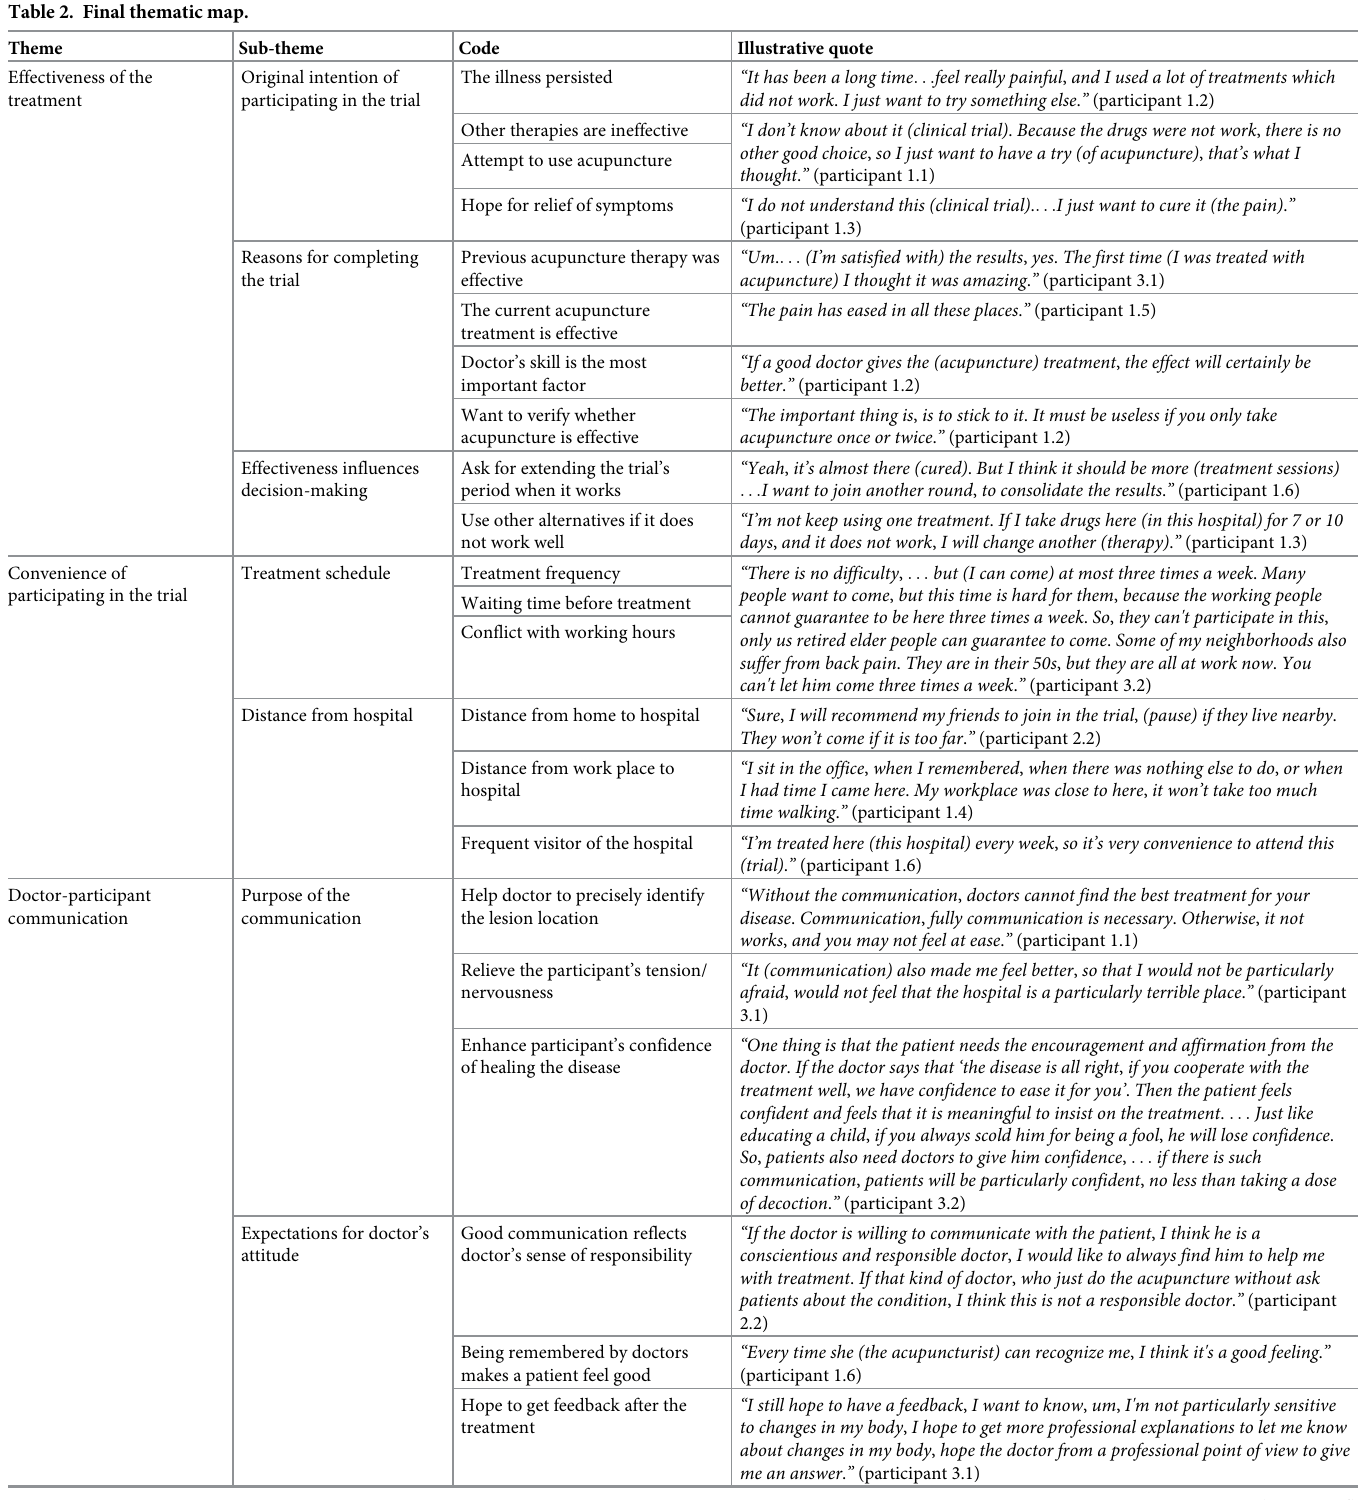
Table 2. Final thematic